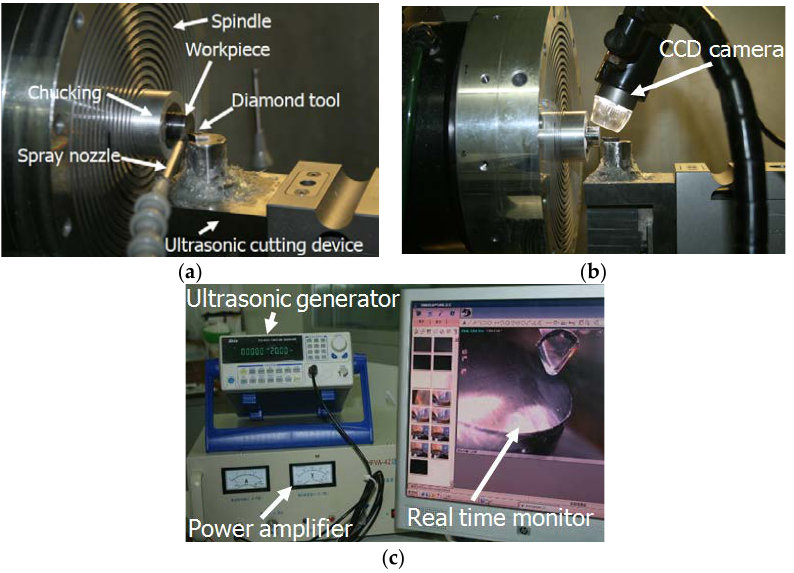
Figure 7. Schematic of the experiment system; ( a ) Cutting end; ( b ) Tool setting assisted by real time monitoring; ( c ) Ultrasonic generator and power amplifier. Table 2. Material properties of tungsten carbide.